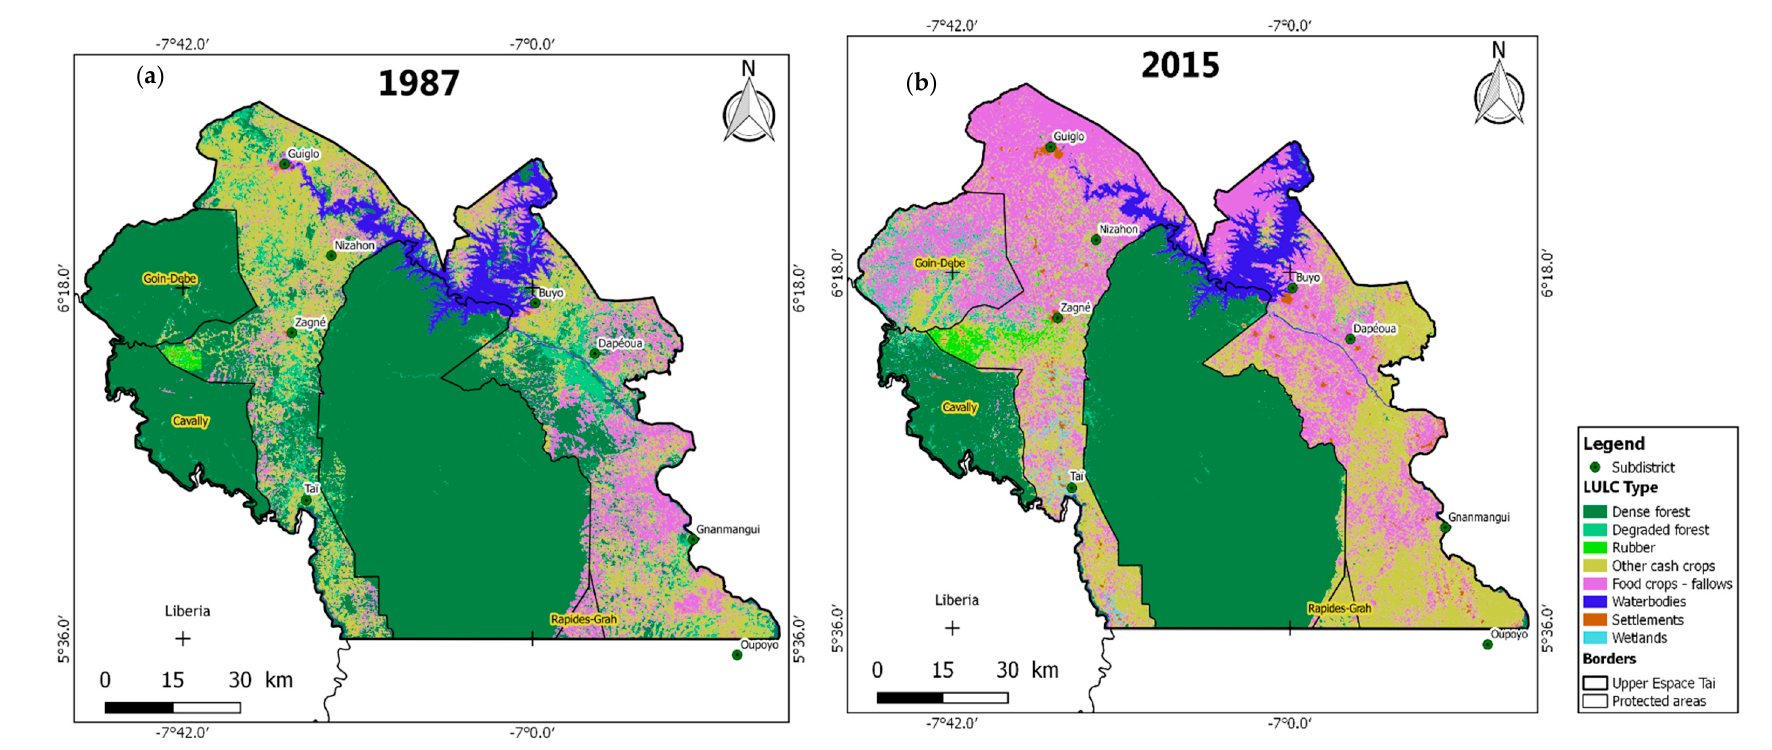
Figure 3. LULC map of 1987 ( a ) and 2015 ( b ) of the Upper Espace Taï , Côte d’Ivoire.